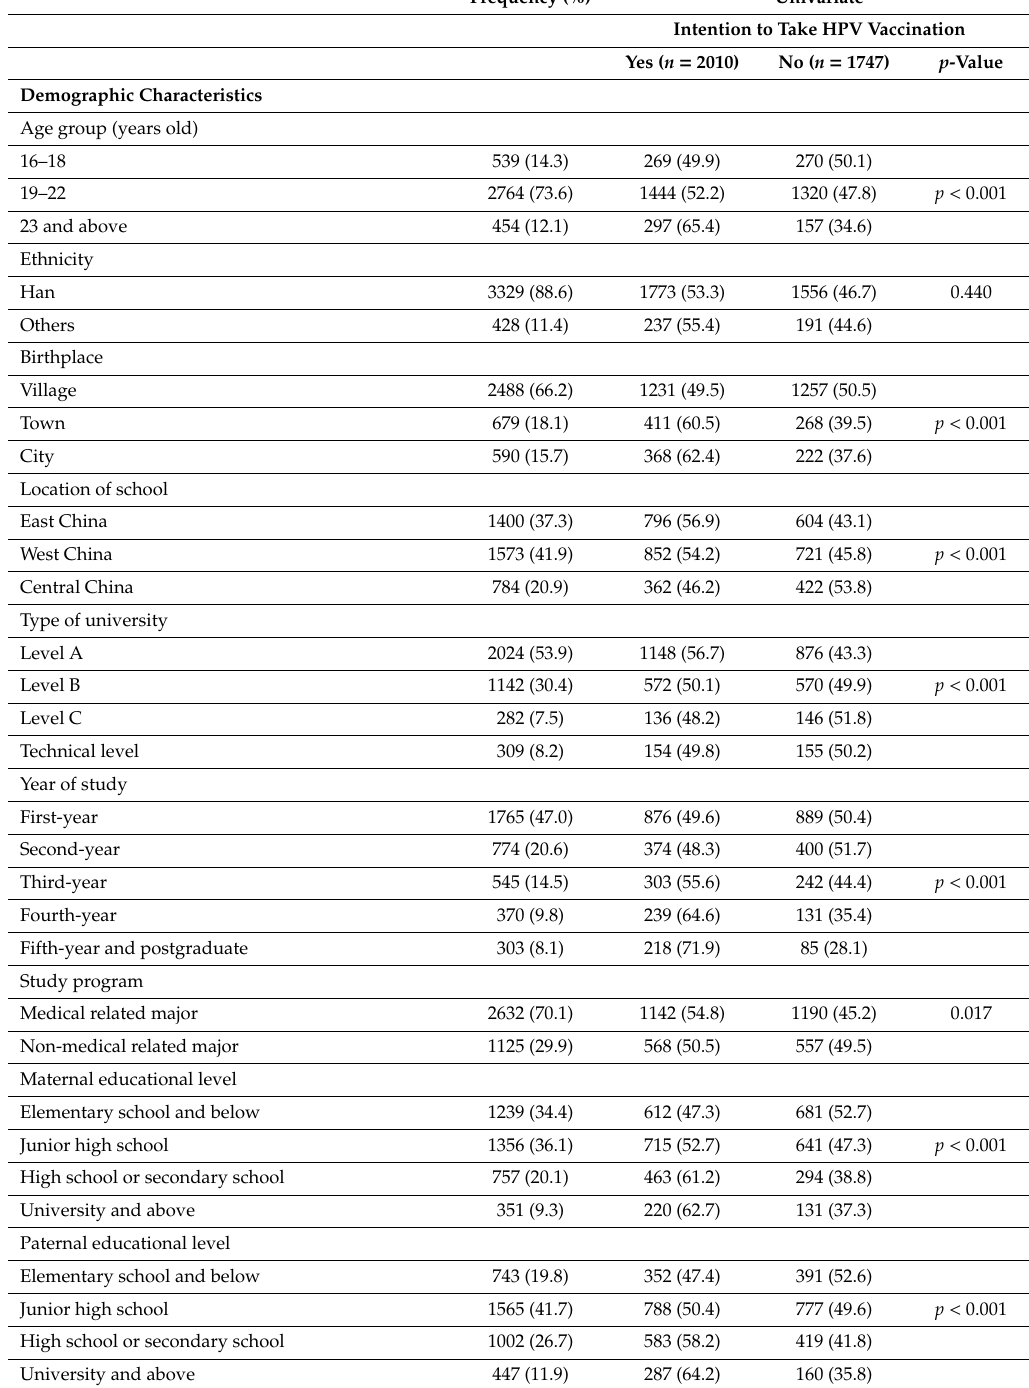
Table 2. Univariate analyses of factors associated with intention to take HPV vaccination ( N =